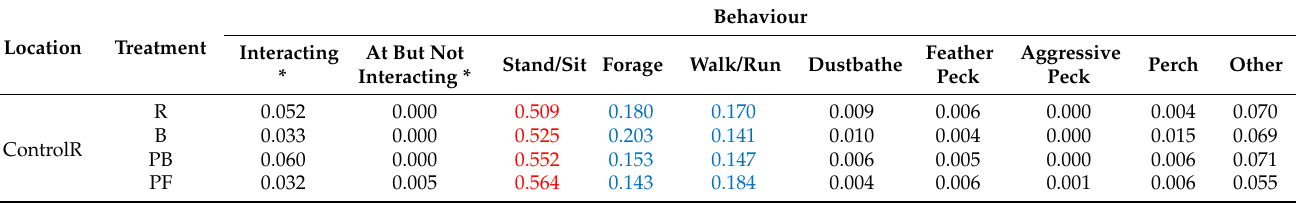
Table 3. The mean over scans of proportions of hens observed by location and treatment in various behaviours. All behaviours were mutually exclusive, and rows within location by treatment add up to 1.0. At ControlR, the only enrichment to interact with was rope; at Away, there were no enrichments. Figures in red are values ≥ 0.500; figures in blue are values between 0.100 and